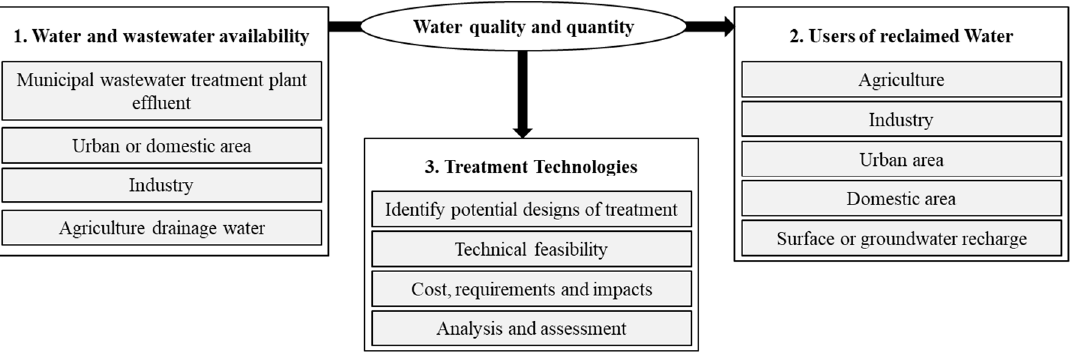
Figure 1. Water reuse for pre-feasibility in a systemic approach: (1) wastewater for reuse, (2) type of intended reuse, and (3) identification and assessment of technology.